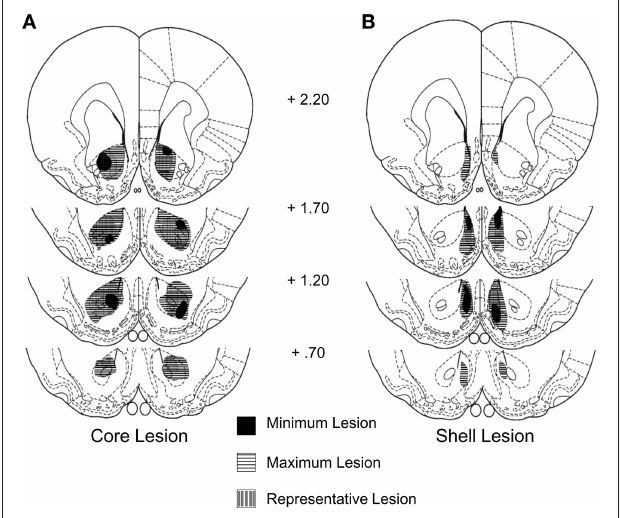
FIGuRe 1 | Neurotoxic lesion of the NA core (A) or shell (B). Traces showing minimum, maximum, and representative